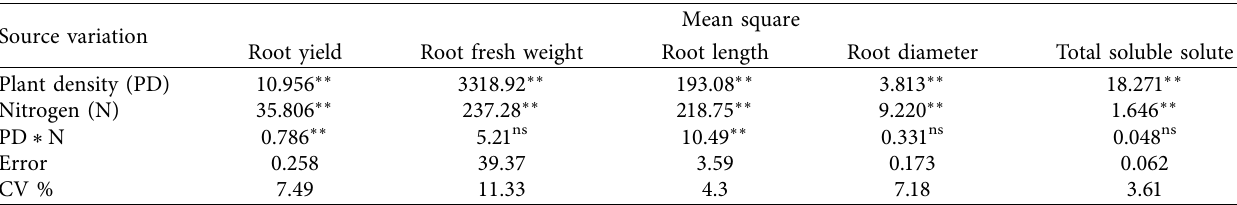
Table 1: Combined analysis of variance showing mean squares for root yield and other parameters of beetroot influenced by plant density and nitrogen fertilizer rates.